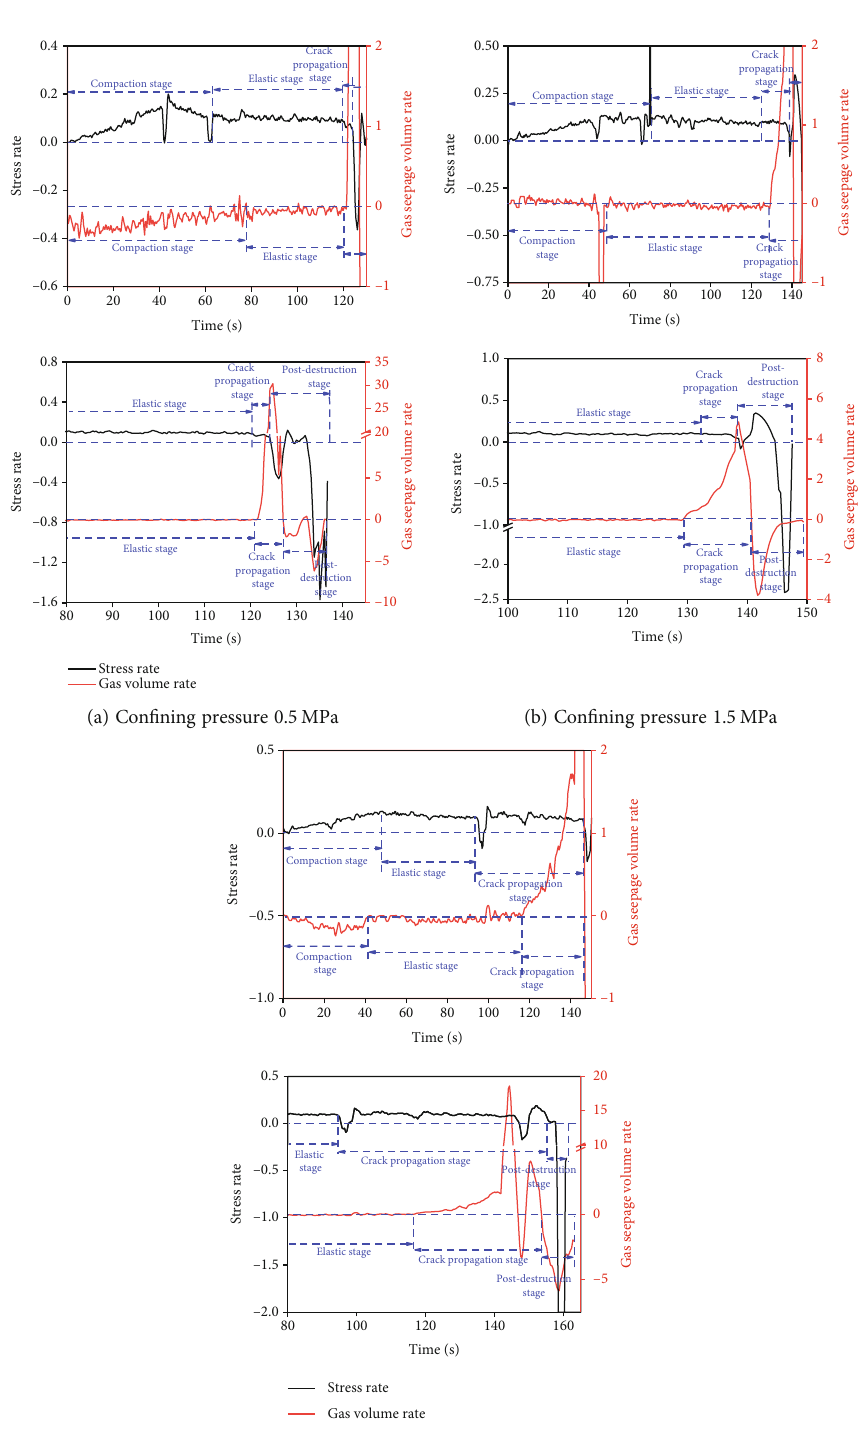
Figure 8: Rate curves of stress and gas seepage volume under di ff erent con fi ning